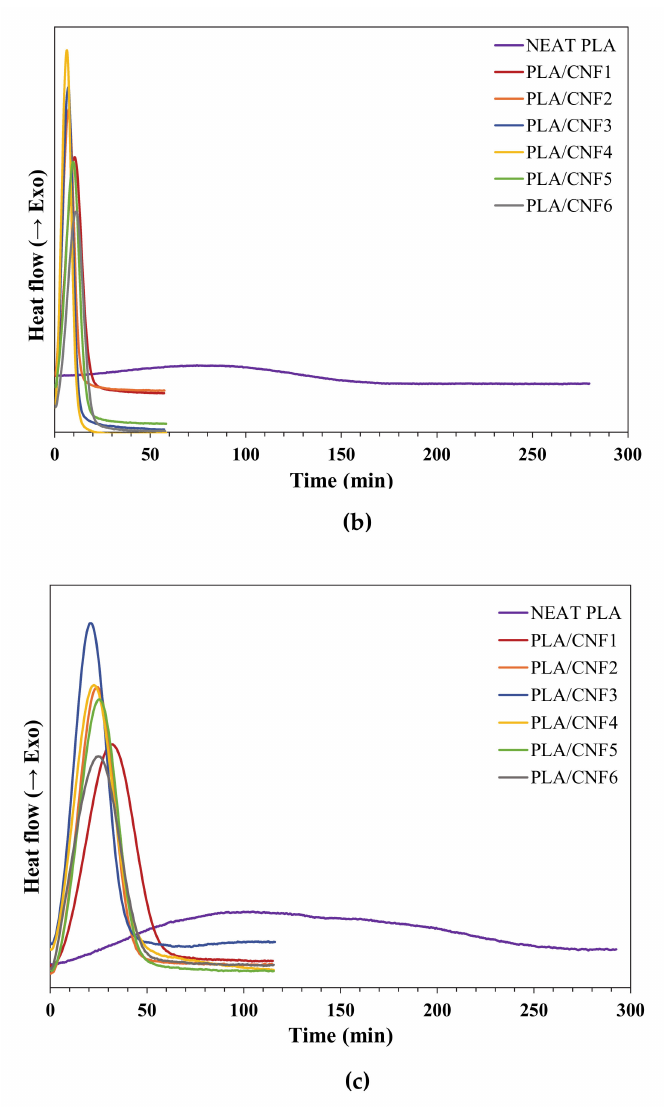
Figure 2. Isothermal crystallization isotherms of neat PLA and PLA/CNF nanocomposites at ( a ) 90, ( b ) 100 and ( c ) 110 ◦